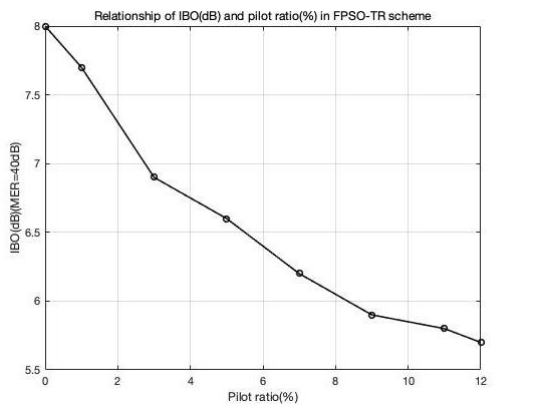
Figure 9. Relationship of IBO (dB) and pilot ratio (%) in F-TR